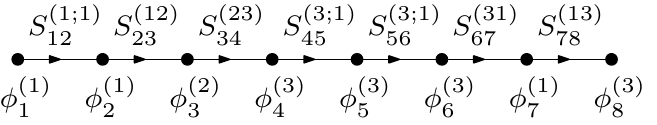
( z ) R (1) ( z ) : : : R (1) ( z ) R (3) ( z ) 1 2 7 8